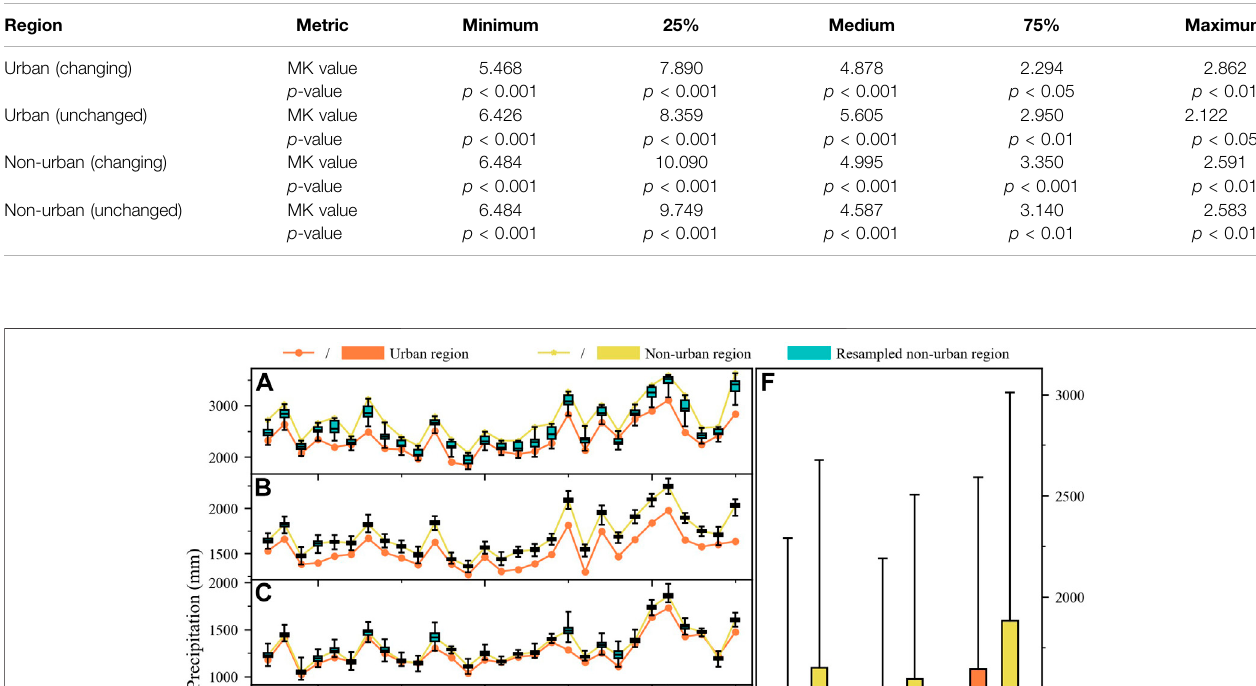
Frontiers in Earth Science |